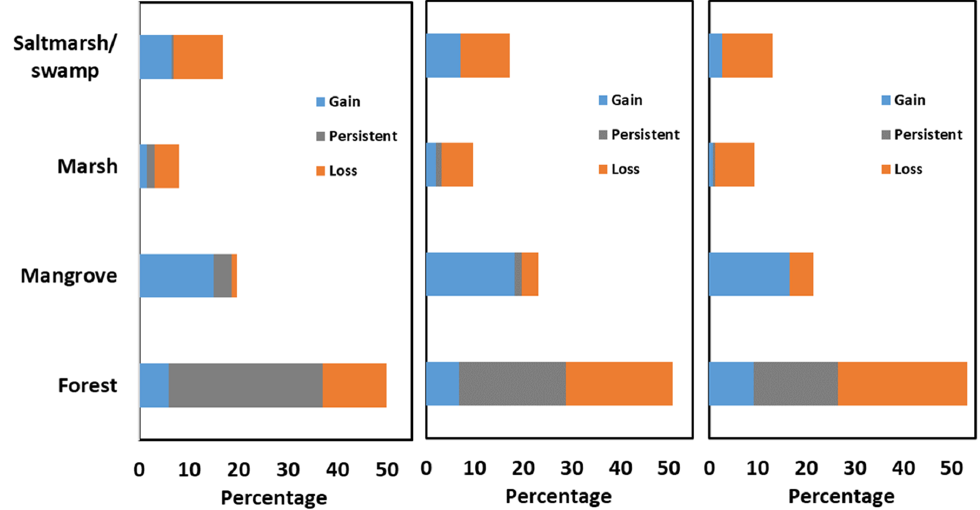
Figure 5. A plot showing the sources of difference (i.e., gain, loss, and persistence) between the predicted present-day and future wetland distribution maps under SLR scenario 1 ( left ), scenario 2 ( middle ), and scenario 3 ( right ) , for each wetland category. The change percentages associated with each class are the proportions of the total area shown in Figure